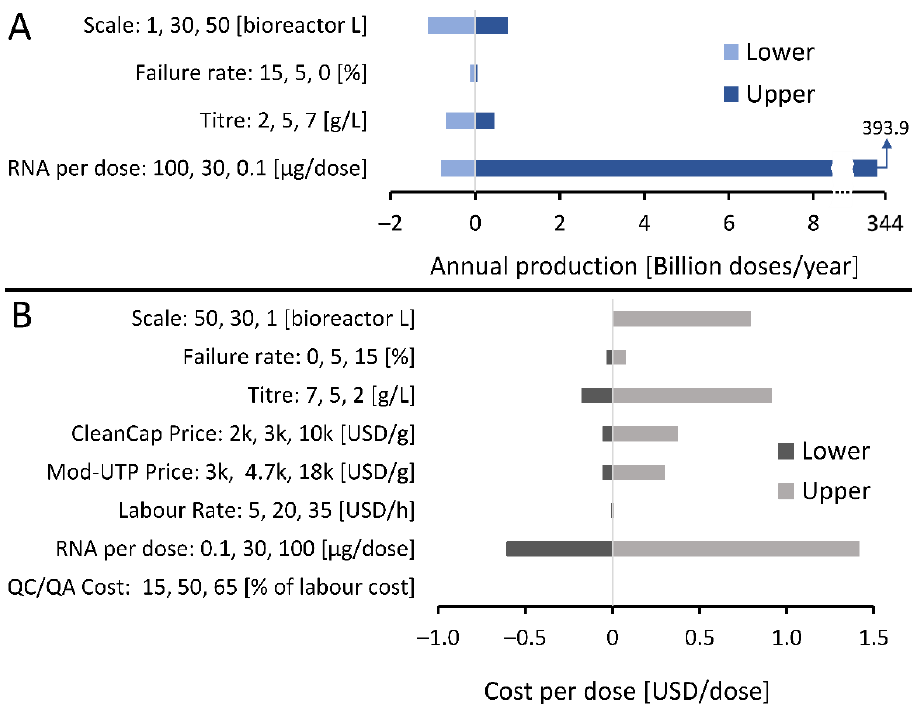
Figure 1. Sensitivity analysis showing RNA vaccine drug substance manufacturing uncertainties and their impact on annual production amounts and costs per dose. Input variables which are uncertain, their uncertainty ranges and units are shown on the vertical y-axis and the outputs of drug substance annual production amounts and costs per dose and shown on the horizontal x-axis. The zero values shown on the horizontal x-axes and the corresponding vertical line indicates a baseline scenario which describes an RNA vaccine production process with a 30 L bioreactor working volume scale, a final titre in the bioreactor of 5 g/L, 44% combined losses in the downstream purification and formulation steps, 30 µ g of RNA per vaccine dose, a production process failure rate of 5%, 5 (cid:48) cap analogue (CleanCap) purchase price of 3000 USD/g, 1-methyl-pseudouridine (Mod-UTP) purchase price of 4700 USD/g, basic labour rate of 20 USD/hour, quality control testing (QC/QA) cost of 50% of the labour costs, and 444–471 production batches completed per year. ( A ) The impact of uncertainties and their ranges listed on the vertical y-axis on the amount of doses worth of lipid nanoparticles (LNP) formulated RNA that can be produced annually shown on the horizontal x-axis. Results are shown relative to a baseline scenario at zero on the x-axis, as described above. ( B ) The impact of uncertainties and their ranges listed on the vertical y-axis on the production cost of the LNP formulated RNA drug substance per dose shown on the horizontal x-axis. Results are shown relative to a baseline scenario at zero on the